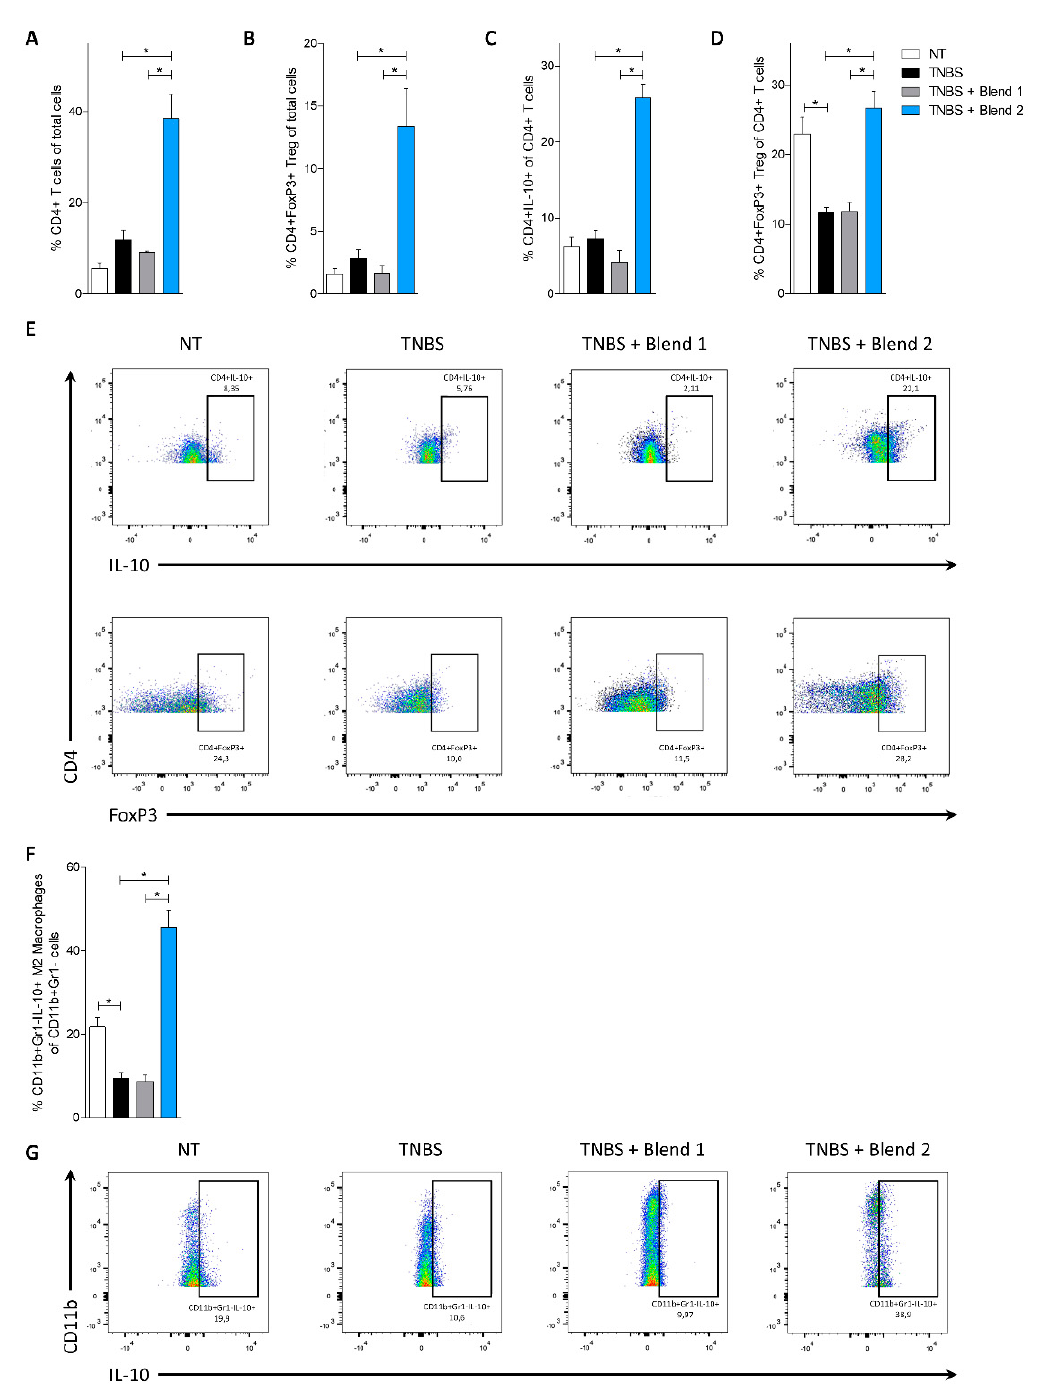
Figure 2. Vivomixx (Blend 2) but not VSL#3 (Blend 1) shapes the colonic lamina propria immune phenotype in the 2,4,6-trinitrobenzenesulfonic acid (TNBS) colitis. Balb/c mice were treated with TNBS as detailed in Materials and Methods and then administered with vehicle or one of the two formulations of probiotics by gavage from day 0 to day 4. Frequency of immune cells in the colonic lamina propria : CD4+ cells ( A ), CD4+FoxP3+ cells ( B and D ), and CD4+IL-10+ cells ( C ). ( E ) Flow cytometry analysis of IL-10 expression and FoxP3 expression in CD4+ cell recruited into lamina propria . ( F ) Frequency of CD11b+Gr1-IL-10+ M2 macrophages in the colonic lamina propria. ( G ) Flow cytometry analysis of Il-10 expression in CD11b+Gr1- macrophages recruited into the lamina propria . Results are the mean ± SEM of 5–7 mice per group. * p < 0.05. Abbreviations are: FoxP3, Forkhead box P3. Other abbreviations are listed in Figure 1.